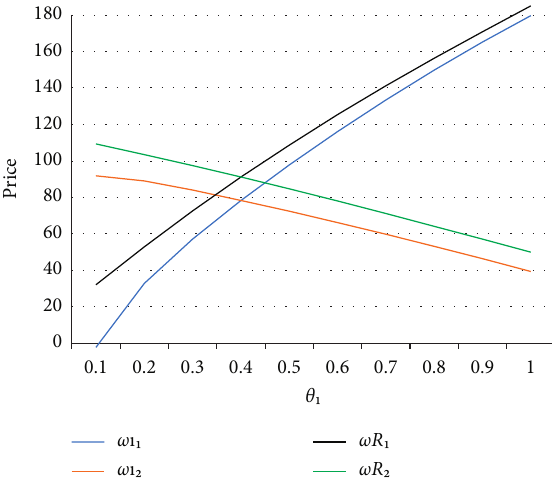
Figure 4: The impact of θ